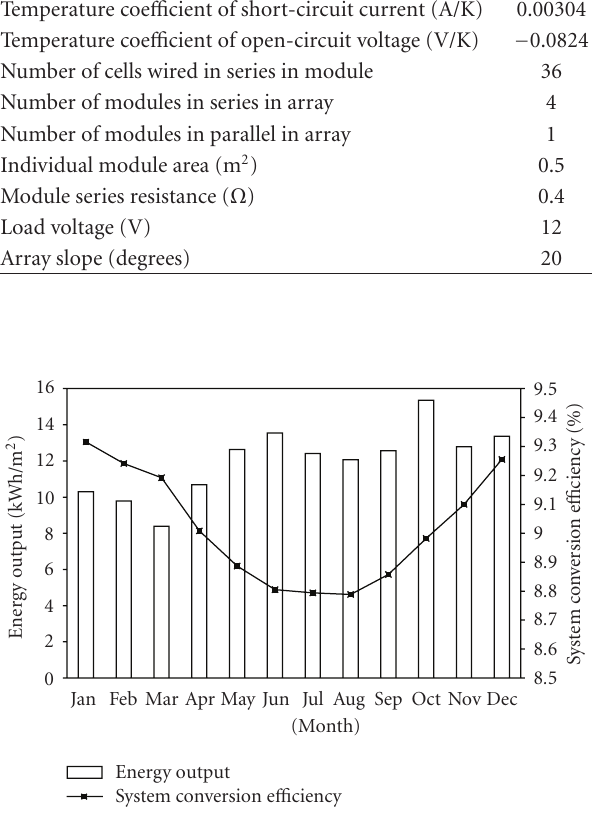
Figure 8: Monthly PV energy output and system conversion e ffi - ciency in